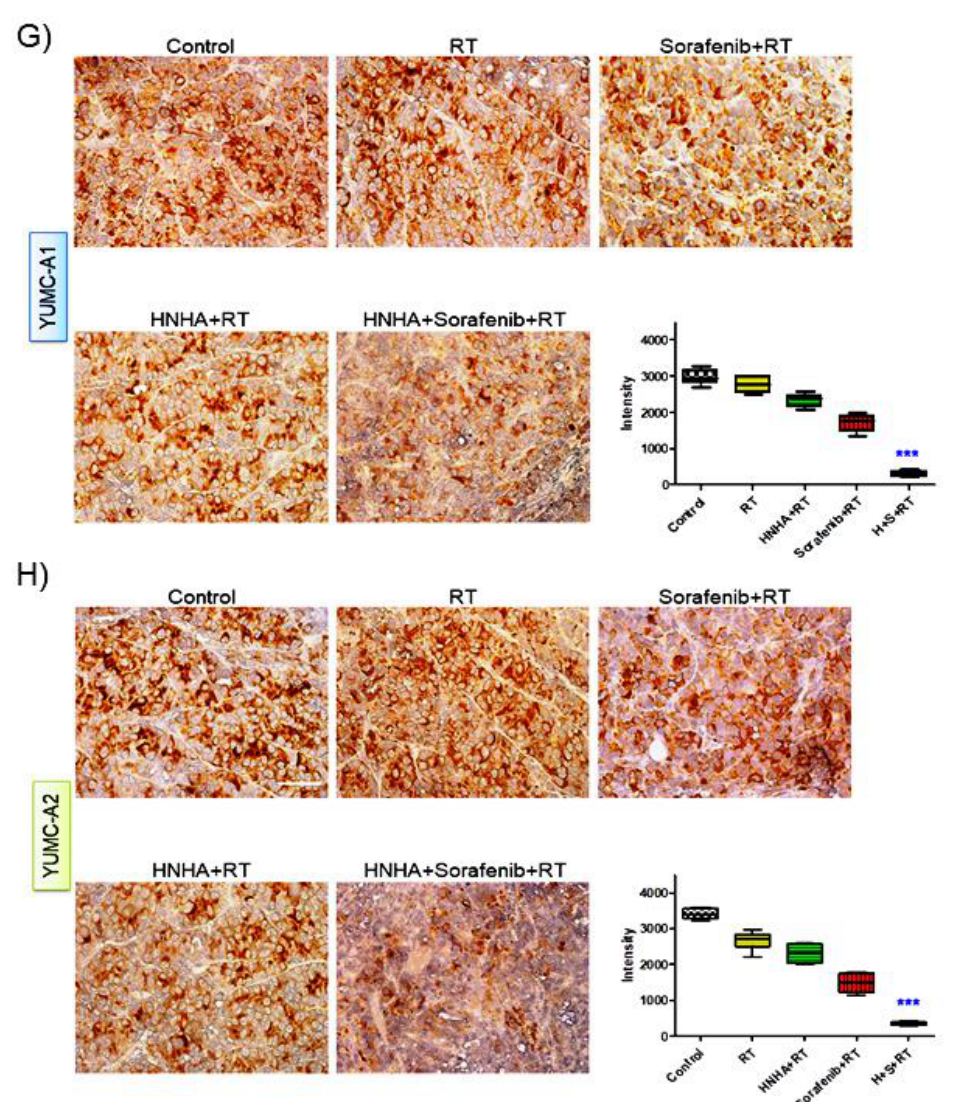
Figure 7. Synergistic anticancer effect of HNHA, sorafenib, and radiation induced the highest tumor shrinkage of ATC cancer cell xenografts in vivo: ( A , B ) Combination of HNHA, sorafenib, and radiation induced a significant inhibition of tumor progression than HNHA or sorafenib with radiation or radiation in patient-derived ATC, YUMC-A1 and YUMC-A2 cell xenografts (n = 10 mice/group). Data represent the mean tumor volumes. Co-treatment with HNHA and sorafenib with radiation showed the maximum reduction in tumor weight of the dissected tumor weight in patient-derived ATC, YUMC-A1 ( C ) and -A2 ( D ) cell xenografts. The compounds had no significant effect on body weight of patient-derived ATC, YUMC-A1 ( E ) and -A2 ( F ) cell xenografted mice. ( G,H ) Immunohistochemical analysis of Bcl-2 proteins in tumor tissues following the indicated treatments. Examined at × 400 magnification; scale bar, 80 µ m. Each assay was performed in triplicate and representative images are displayed. * p < 0.05, ** p < 0.01, and *** p < 0.005 vs. control. MetaMorph 4.6 image-analysis software was used to quantify the immunostained target pro- tein.